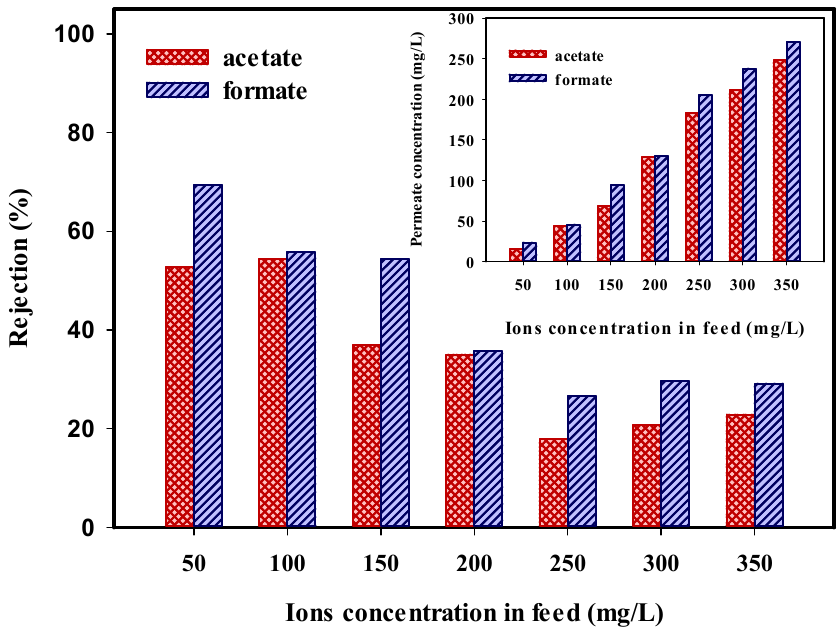
Figure 6. Effect of ions concentration in the feed on the rejection of the binary mixtures (acetate and formate) in the 45 wt.% MDEA solutions (Feed flow: 0.693 L / h; Pressure: 70 bar; Temp: 35 ◦ C; pH: 10). Insert: Effect of ions concentration in the feed on the permeate concentration.